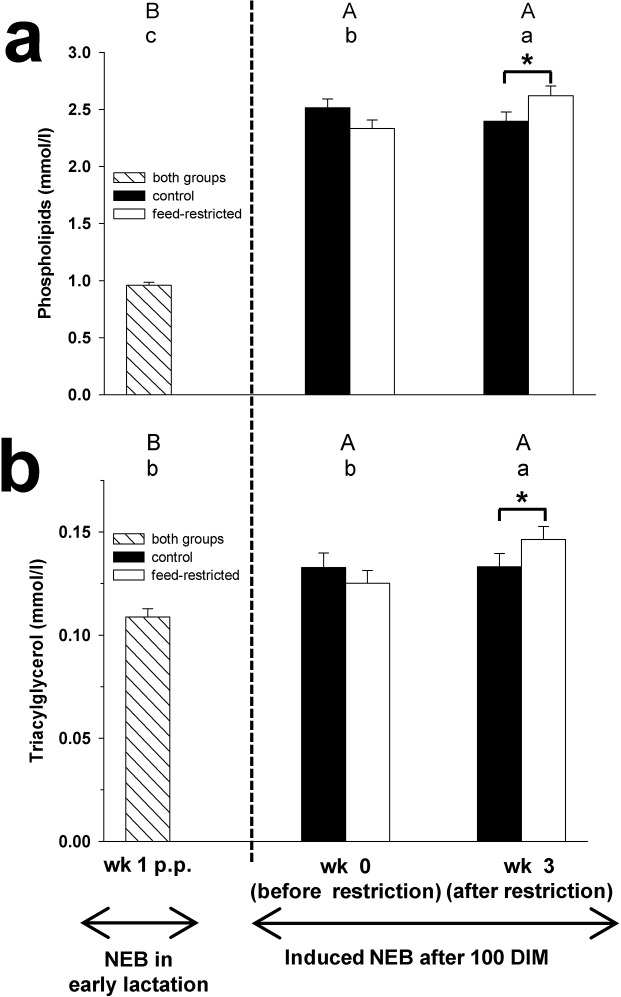
Phospholipids and TAG.Plasma concentration of phospholipids (Fig 3a) and triacylgycerol (Fig 3b) in week 1 p.p., and before (week 0) and after (week 3) feed restriction in mid-lactation. Changes over time within the groups are marked with superscripts (A to C for the control group (CON); a to c for the feed-restricted group (RES); P < 0.05). Differences between control (CON) and feed-restricted (RES) group in week 3 are indicated by * (P < 0.05). Data are presented as means ± standard error of the mean.